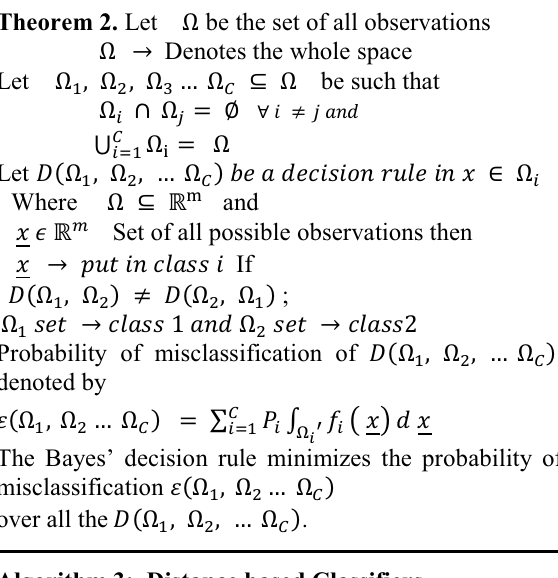
Algorithm 3: Distance based